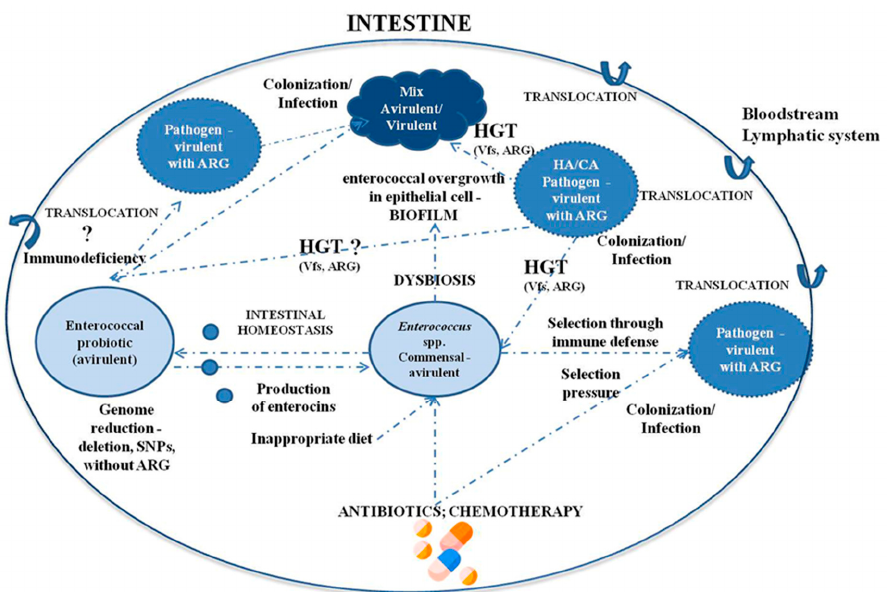
Figure 2. The relationships between enterococci in the transition towards pathogenicity. Legend: HGT—horizontal gene transfer; Vfs—virulence factors, ARG—antibiotic resistance gene. Antibiotics, chemotherapeutics, and diet can alter the composition of the gut microbiota. The overgrowth of Enterococcus causes dysbiosis and often disorders homeostasis. Biofilm is a key process in horizontal gene transfer (HGT). Transfer antibiotic resistance genes and virulence factors are facilitated. Commensal strains and probiotic strains can convert into pathogenic strains. For oncological patients and people with a weakened immune system, the translocation of pathogenic strains into the circulatory system is highly likely. Table 1. Advantages and disadvantages of enterococci.